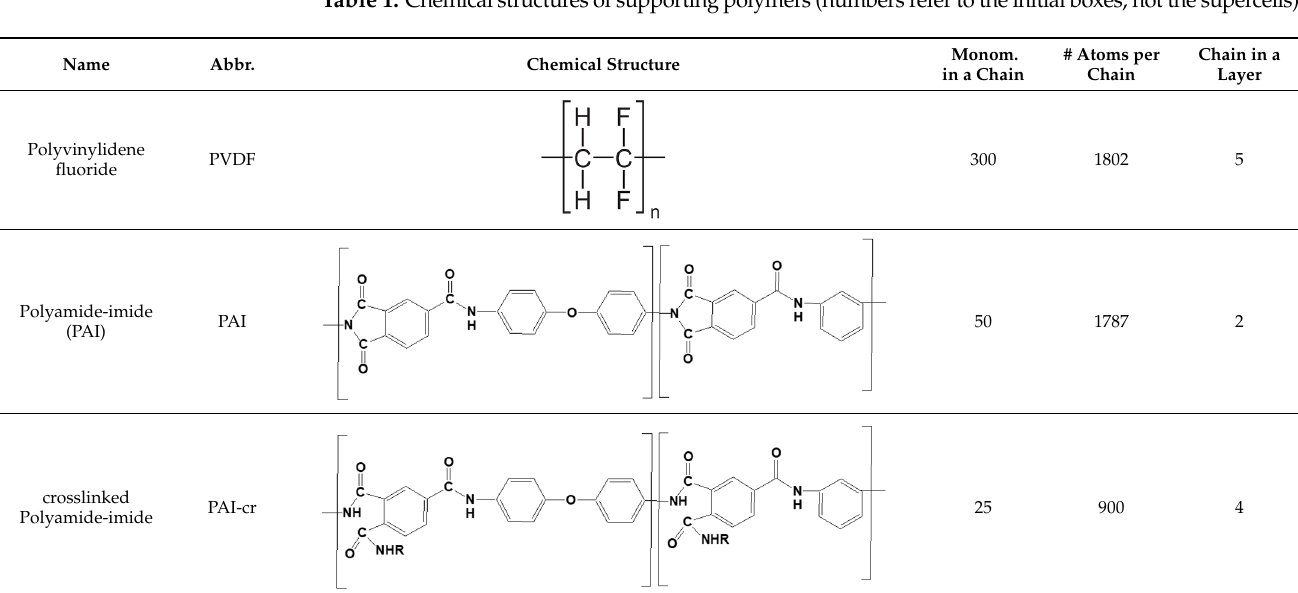
Table 1. Chemical structures of supporting polymers (numbers refer to the initial boxes, not the supercells).